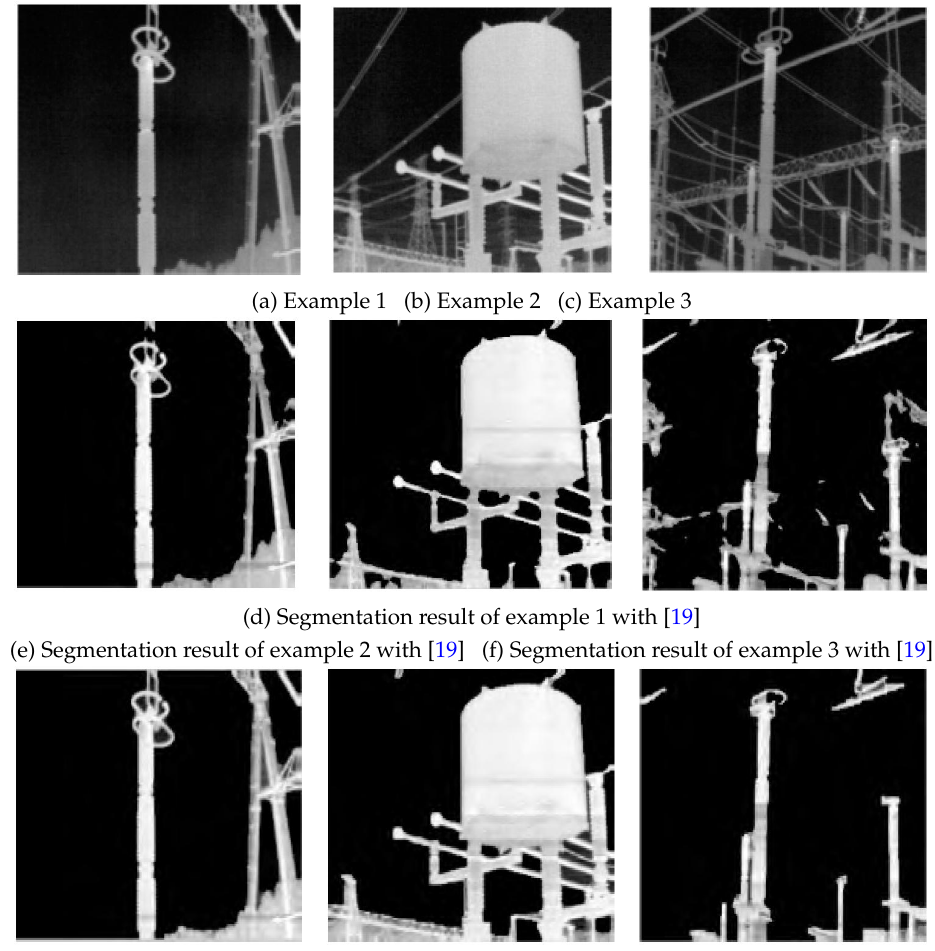
Fig. 5. Comparisons of model